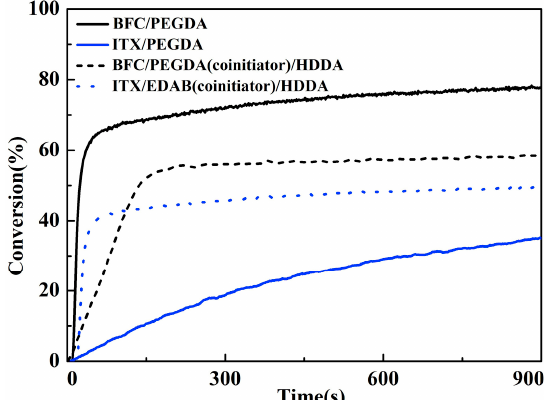
Figure 3. Monomer conversions obtained with ITX and BFC using different photoinitiating systems: BFC (0.0625 %wt)/PEGDA, ITX (0.0625 %wt)/PEGDA, BFC (0.0625 %wt)/PEGDA (5 %wt)/HDDA, ITX (0.0625 %wt)/EDAB (5 %wt)/HDDA upon irradiation with a LED emitting at 405 nm, 70 mW/cm 2 . Reproduced with permission of Ref. [221].